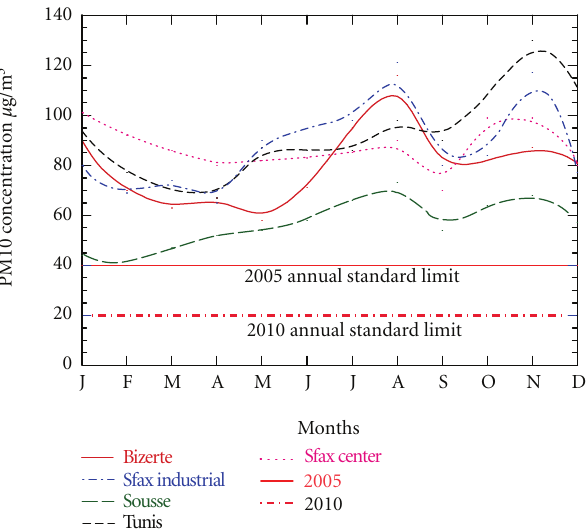
Figure 2: PM10 monthly averaged concentration recorded at the selected monitoring stations from January to December. (Solid and dashed lines are smooth curve fits).